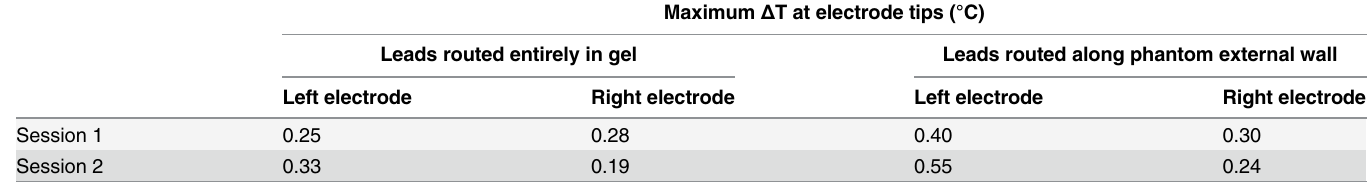
Table 1. The effect of lead immersion in the phantom